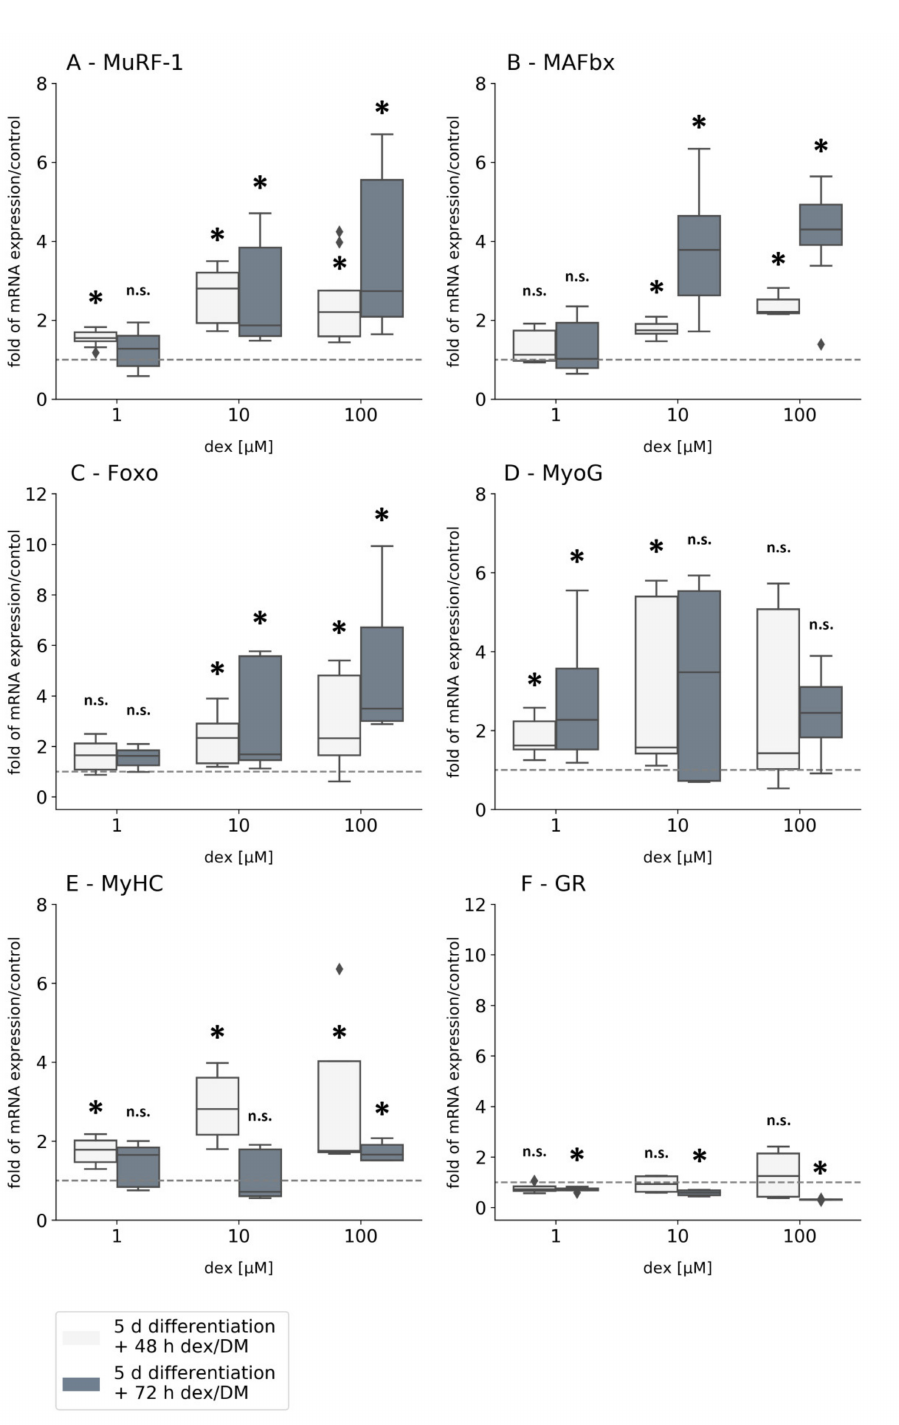
Figure 4. Gene expression analysis of MuRF-1 ( A ), MAFbx ( B ), Foxo ( C ), MyoG ( D ), MyHC ( E ), and GR ( F ) in primary human myotubes after dex treatment. The mRNA levels were normalized to GAPDH and calculated as ratios in relation to the untreated control group (interrupted line). Experiments were performed in triplicates with myoblasts isolated from three di ff erent specimens ( n = 9). Results are presented as medians and quartiles, and p values < 0.05 indicate statistical significance (* p < 0.05), and p values > 0.05 indicate no statistical significance (n.s. > 0.05). Rhombs are presented as